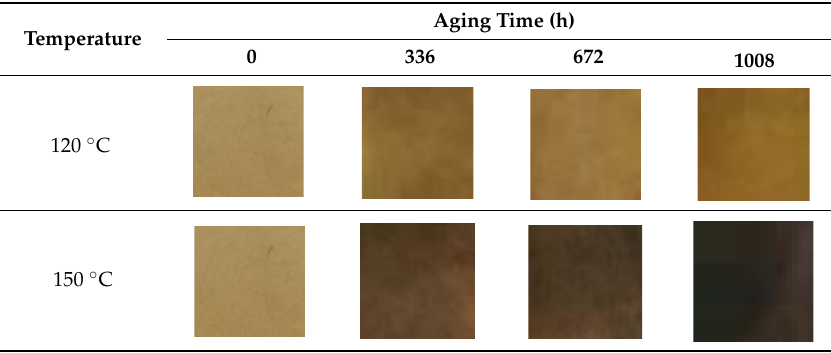
Table 2. Visual appearances of the paper sample.